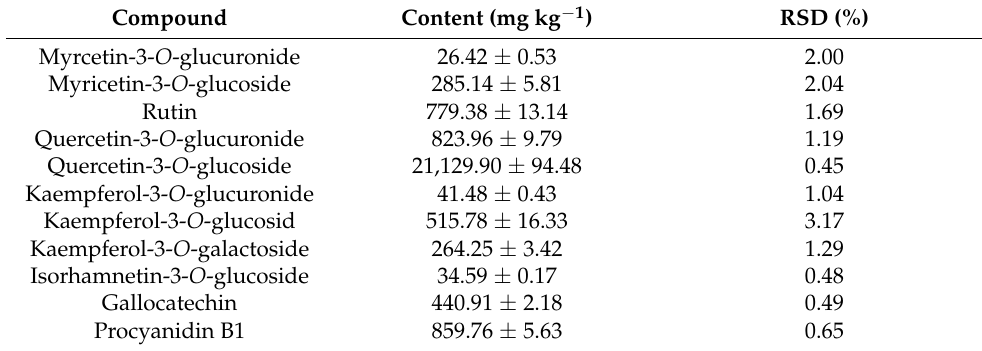
Table 4. Content (mg kg − 1 ) and RSD (%) of each identified